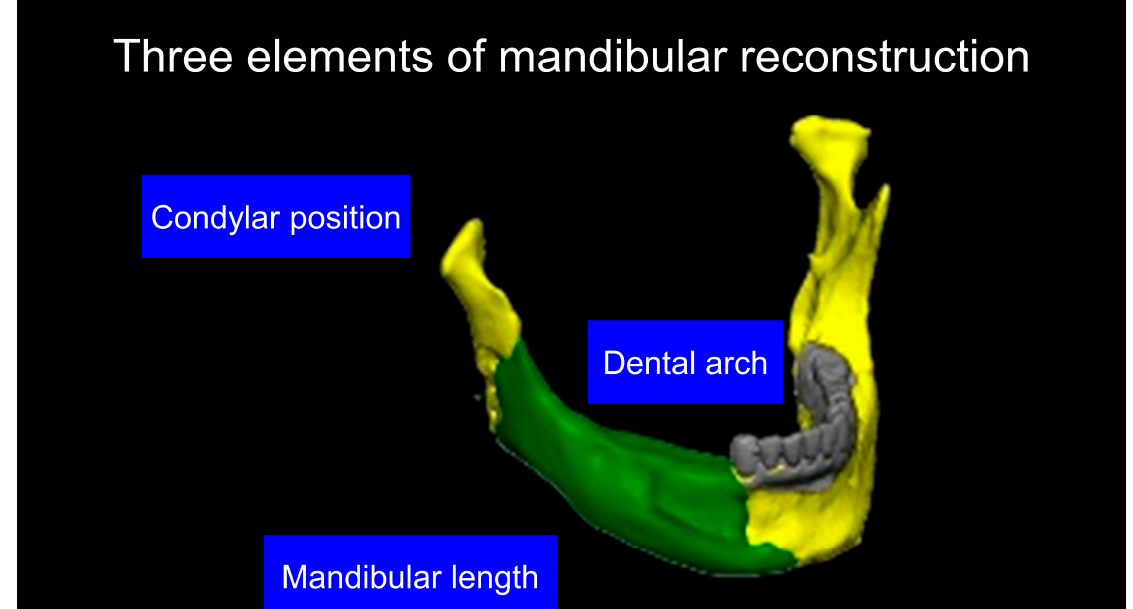
Figure 3. Schematic description of the mandibular reconstruction concept. The important points are condylar position, mandibular body length, and dental arch. A dental arch means that occlusion with the support of natural teeth or with dentures can be established with the optimum inter-occlusal relationship.